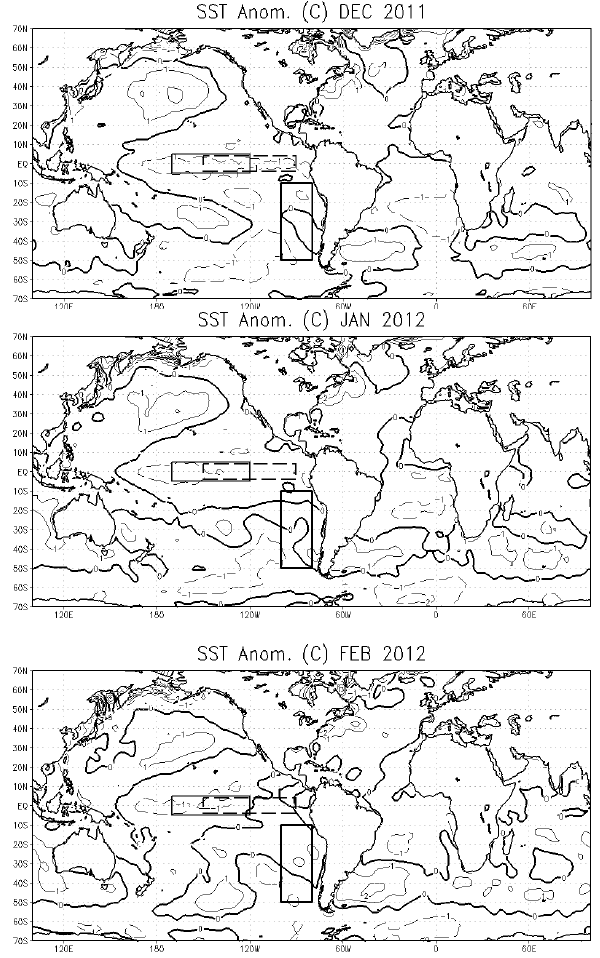
Fig. 3. Monthly mean SST anomalies ( ◦ C) for Dec 2011, Jan 2012 and Feb 2012 relative to their equivalent long-term mean of Figure 3 Monthly mean SST anomalies (  C) Dec 2011, Jan 2012 and Feb 2012 1958–2011 (negative values are indicated by dashed contours). The relative to their equivalent long-term mean of 1958-2011 (negative values are three boxes depicted are in (a) . Niño 3 (long dashed frame): 4 ◦ indicated by dashed contours). The three boxes depicted in are (a). Nino 3 (long dashed frame): 4  S-4  N, 150  W-90  W, Nino 3.4 (solid frame): 5  S-5  N, 170  W-